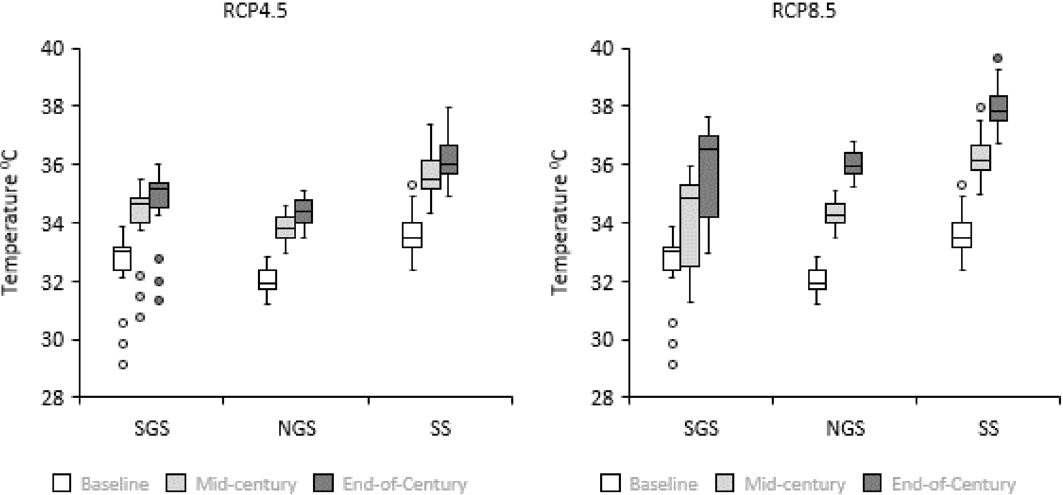
Figure 2. Thirty years seasonal maximum temperature for baseline (1980–2009) and ensemble mid–century (2040–2069) and end of century (2070–2099) periods under RCP4.5 (left) and RCP8.5 (right) in SGS, NGS and SS. Extremes on whiskers (two lines outside the box) encompass the range between lowest and highest values, the box spans the interquartile range, extremes of the box encompass the range between the 25 and 75% quartiles, and the horizontal line within each box section shows the median. Circles located outside the whiskers referred to as